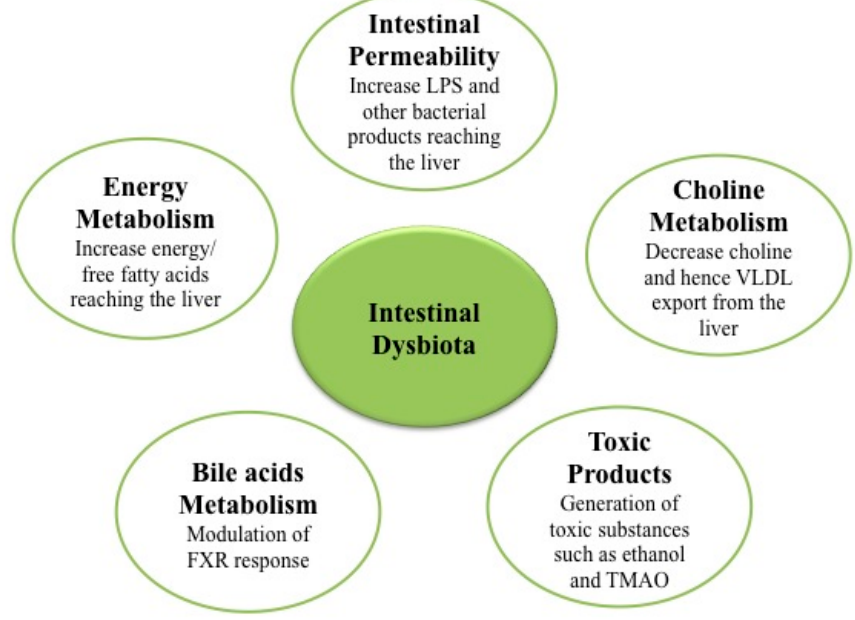
Figure 1. Nonalcoholic fatty liver disease (NAFLD) associated mechanisms of intestinal